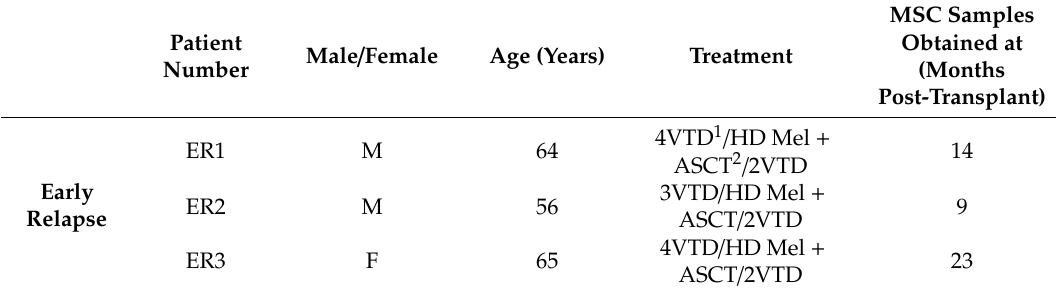
Table 1. Patient